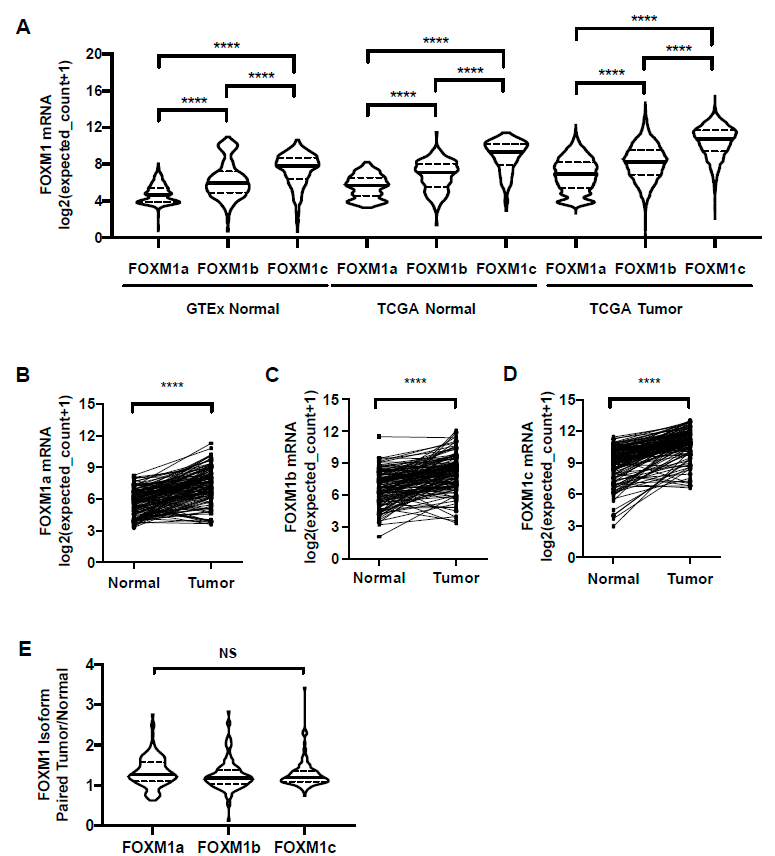
Figure 8. FOXM1 isoform expression in GTEx normal, TCGA normal, and TCGA cancer tissues. ( A )